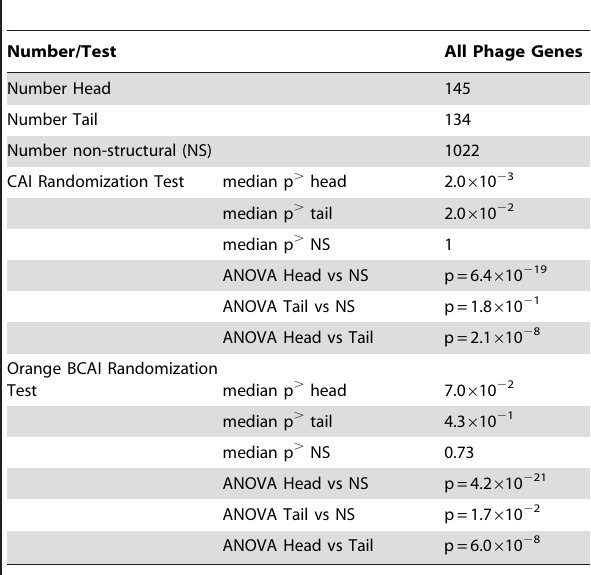
Table 4. Comparison between codon usage and refined structural annotations.